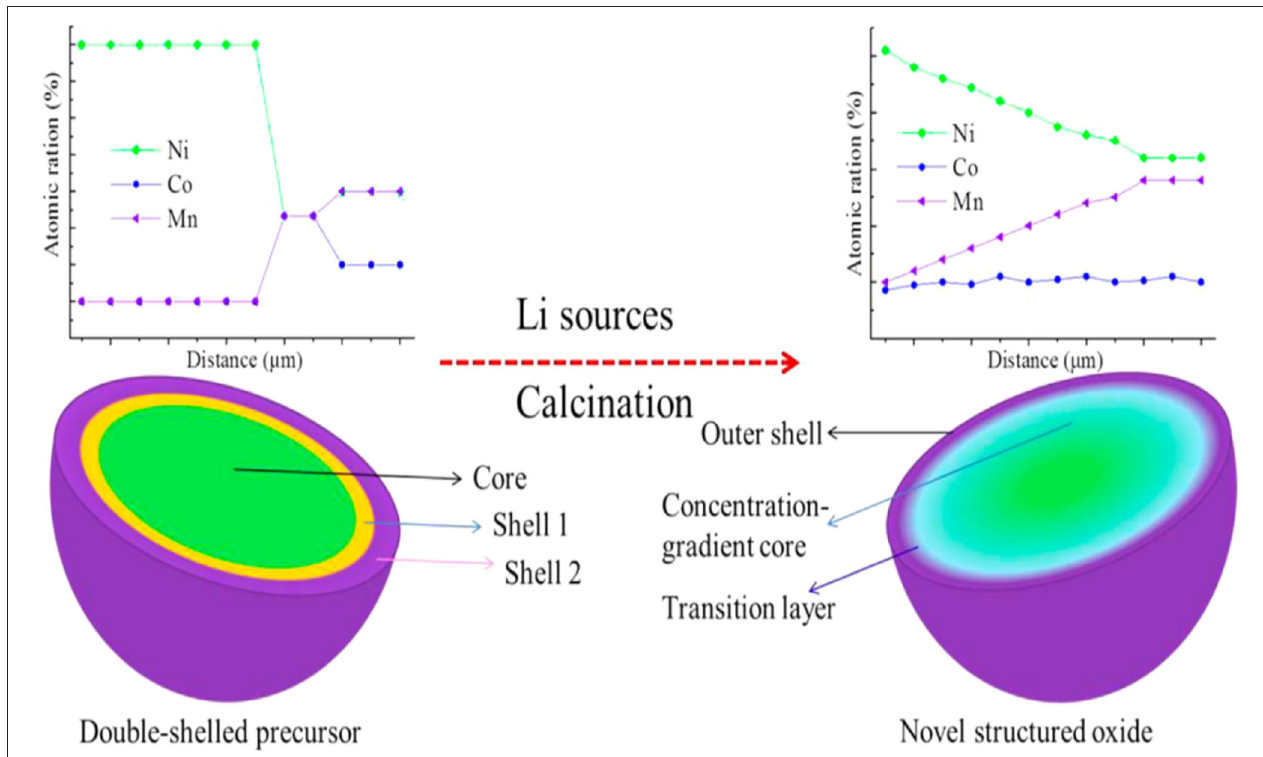
FIGURE 2 | Schematic diagram of using a multi-shell precursor to control a positive electrode with a high nickel concentration gradient. maximum discharge capacity of 188 mAh · g − 1 . The FCG cathode material that gradually changes from Li[Ni 0.86 Co 0.07 Mn 0.07 ]O 2 at the center of the particle to Li[Ni 0.67 Co 0.09 Mn 0.24 ]O 2 at the surface shows high capacity performance (Noh et al., 2014). Full concentration gradient core-shell material LiNi 0.7 Co 0.10 Mn 0.2 O 2 has higher cycle performance and high temperature stability and rate performance (Liang et al., 2015). The relative molar content of Ni in the full concentration gradient core-shell material LiNi 0.8 Co 0.1 Mn 0.12 cathode material gradually decreases from 84% to 76%, the relative molar content of Mn gradually increases, and the Co content shows a slow gradient variation. The capacity retention rate of this material after 100 cycles at 5C rate reaches 90% (Jiang et al.,